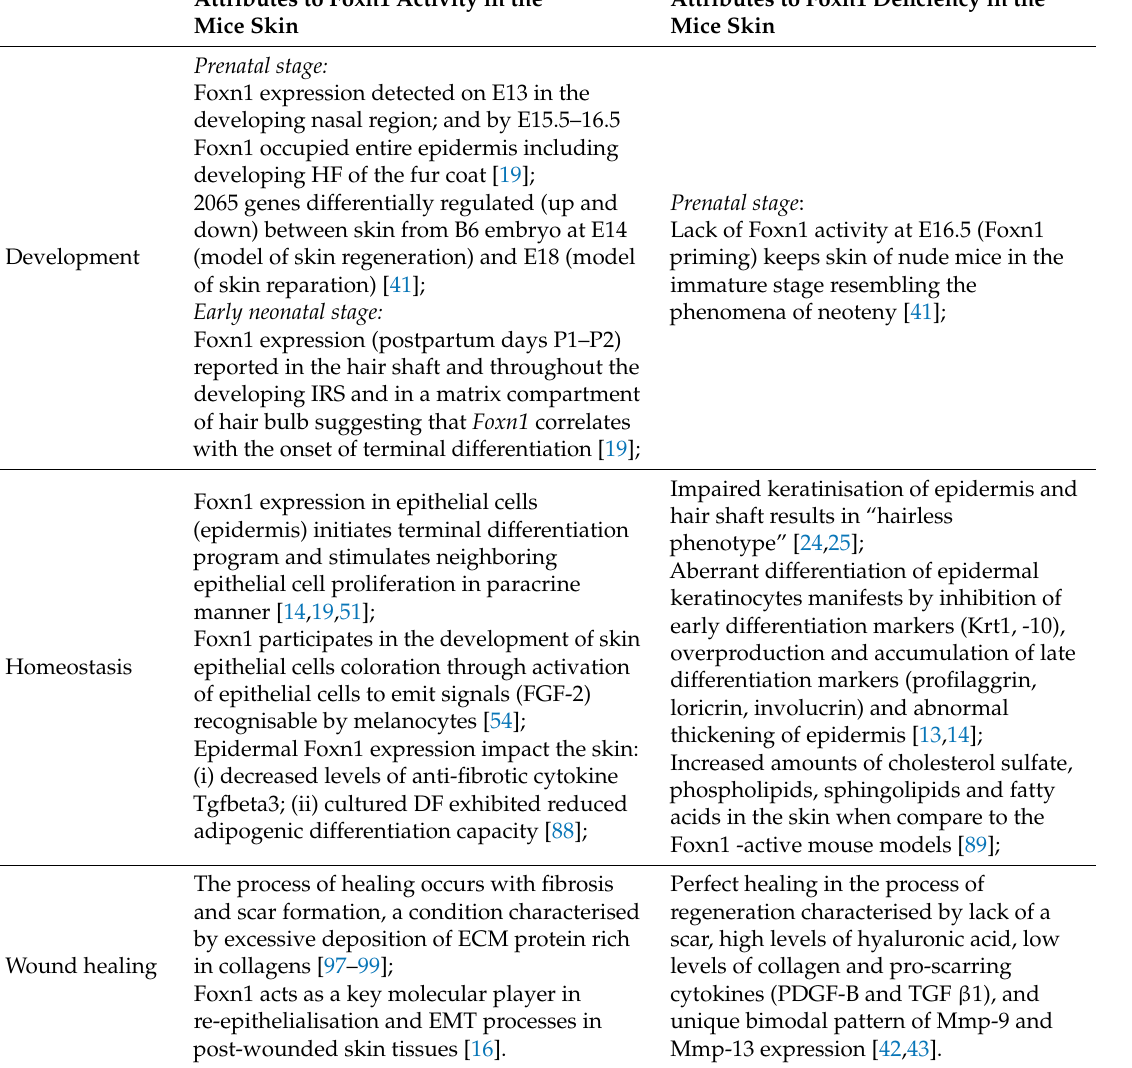
Table 2. Characteristic features of skin physiology attributed to Foxn1 activity or Foxn1